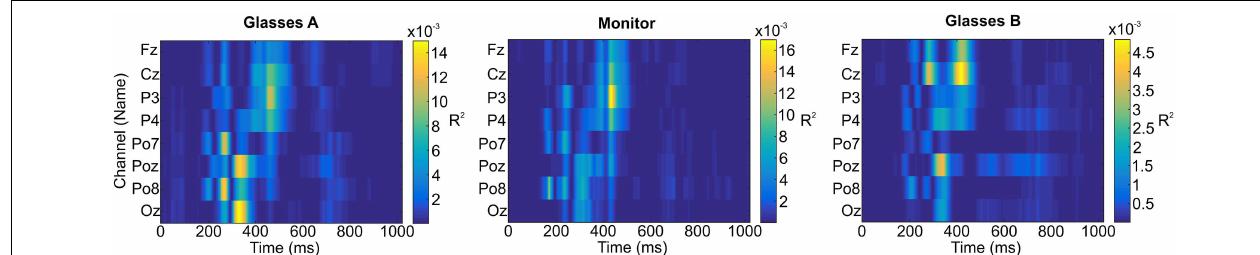
FIGURE 7 | R 2 plots for the glasses A condition, the monitor and the glasses B condition.